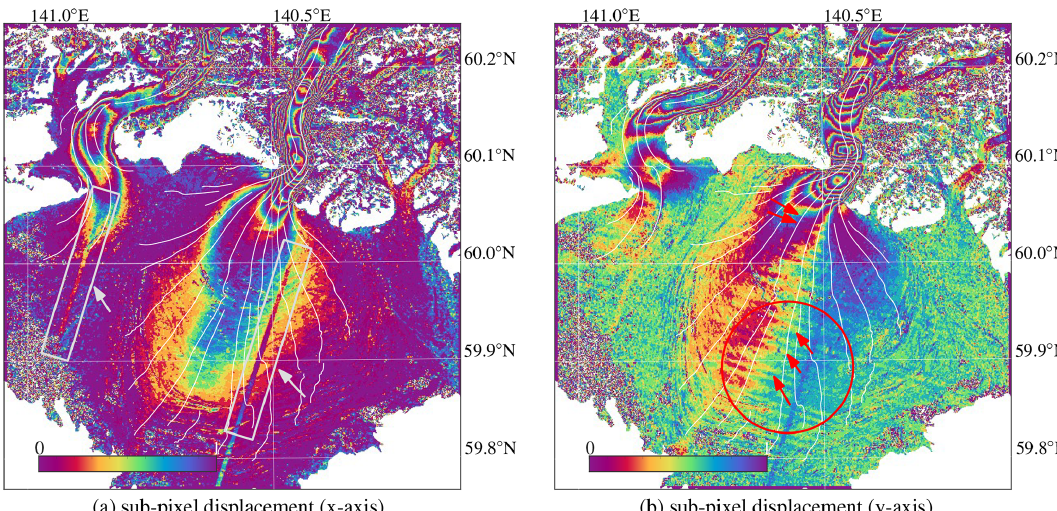
Figure D2. Rainbow-color-coded remainder of the modulus of displacement, for the horizontal and vertical direction ( a , b ). The gray arrows and boxes show displacement artifacts due to internal sensor alignments. The red circles and arrows indicate oscillations that stem from similar internal registration